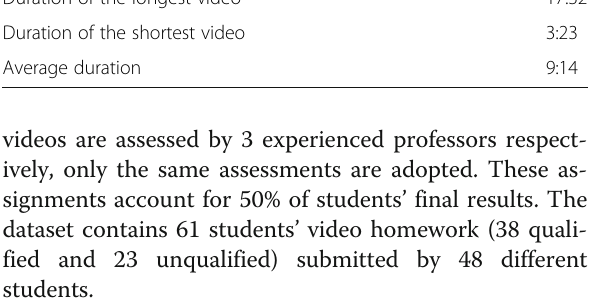
Table 1 Video duration information Number of video segments